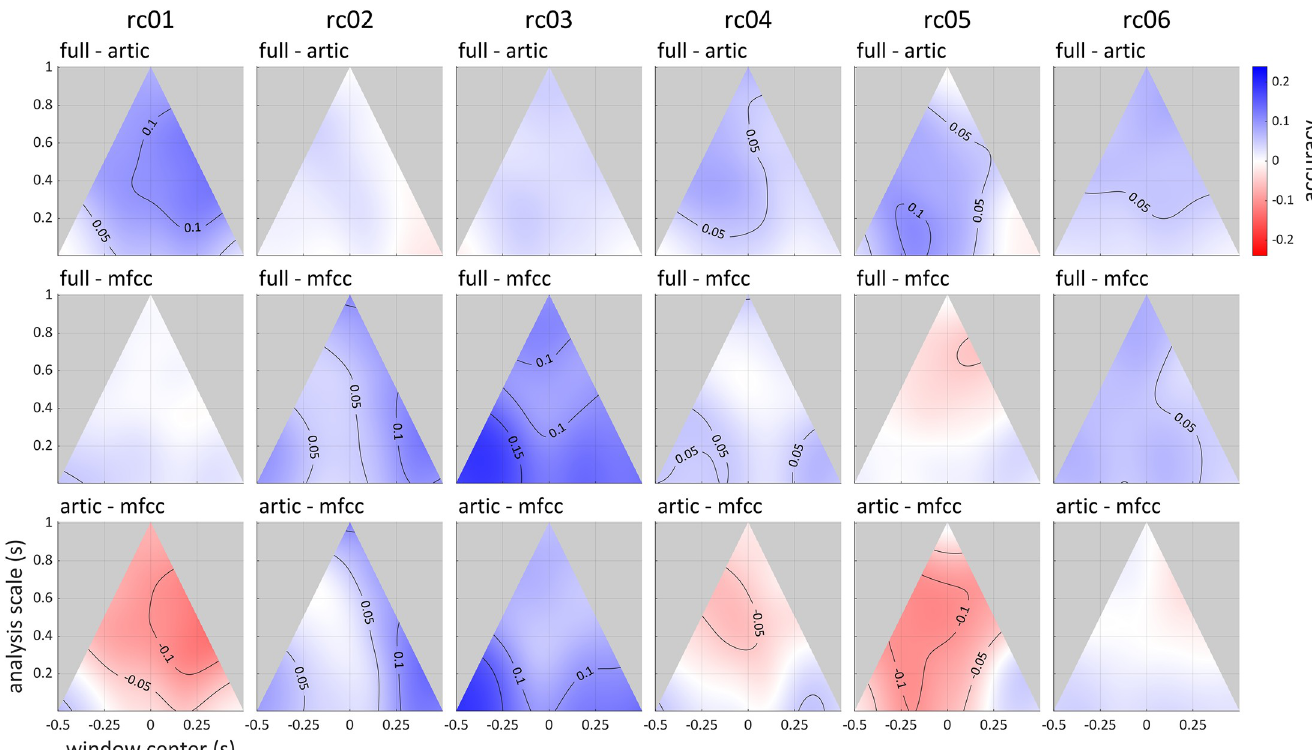
Fig 12. Differences of scalograms showing loss of classification accuracy obtained from removing acoustic (mfcc) or articulatory (artic) subsets of signal dimensions. Top row: articulatory dimensions removed; middle row: acoustic dimensions removed. Blue corresponds to a loss of accuracy. Bottom row: difference in accuracies between analyses restricted to articulatory or acoustic